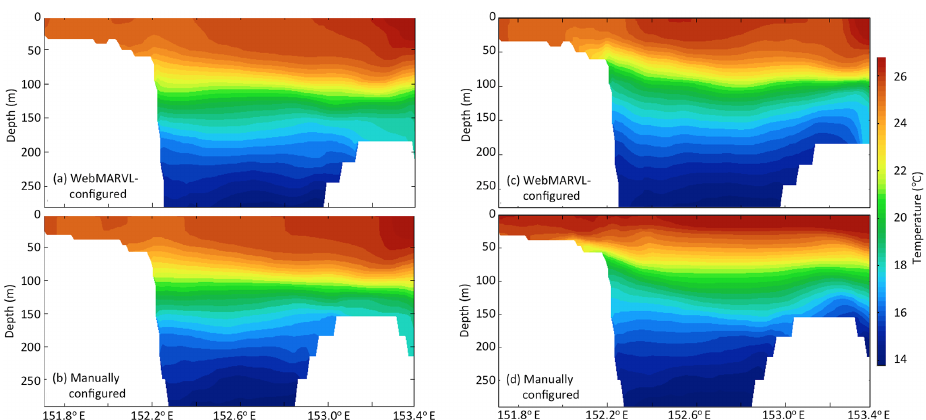
Figure 5. Comparison of a temperature section off the Southern Great Barrier Reef (Fig. 4) from the SHOC model, using (a, c) a WebMARVL configuration and (b, d) a manual configuration for (a–b) 1 December 2008 and (c–d) 18 December 2008.